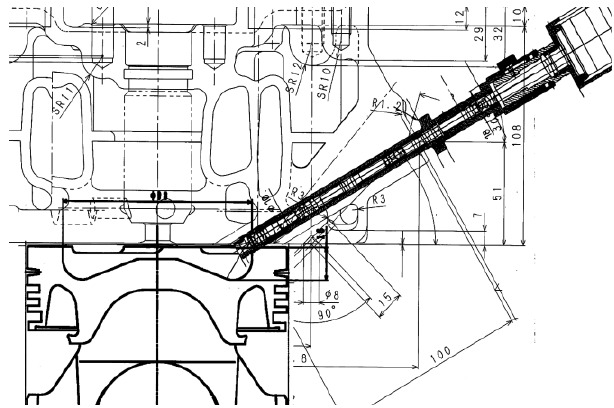
Fig. 3. Cross section of piston combustion chamber and the improved bore scope